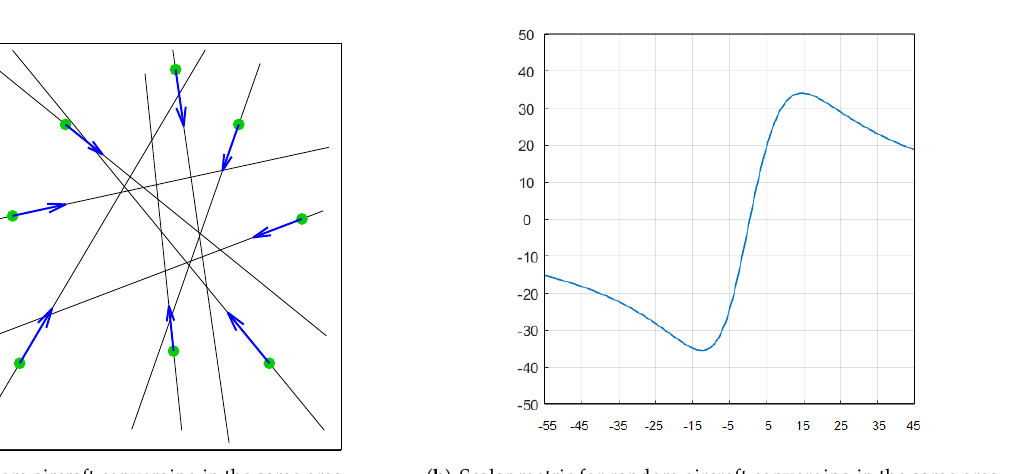
Figure 14. Complexity evolution with time associated to the fuzzy convergence situation.